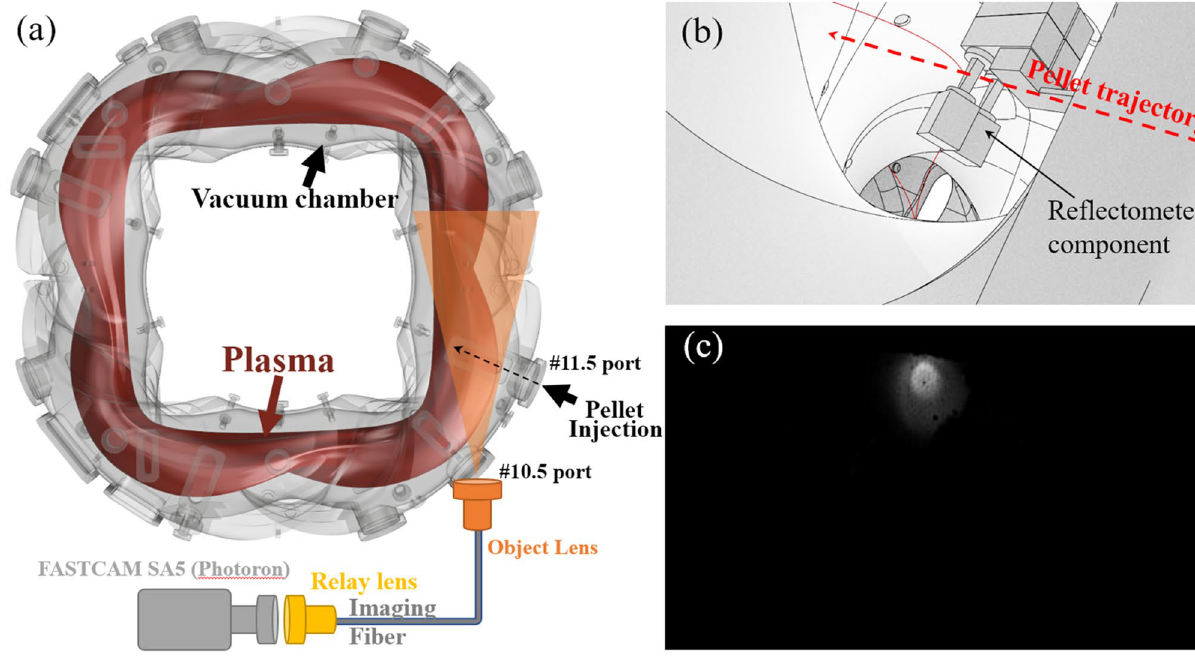
Figure 1. ( a ) Schematic of the fast camera system in Heliotron J. The figure was drawn by “Fusion 360”. ( b ) Field of view of the fast camera system reconstructed as a 3D model, drawn by “Blender”. ( c ) Typical snapshot image of the fast camera in a pellet experiment (shot#79188). See supplementary video